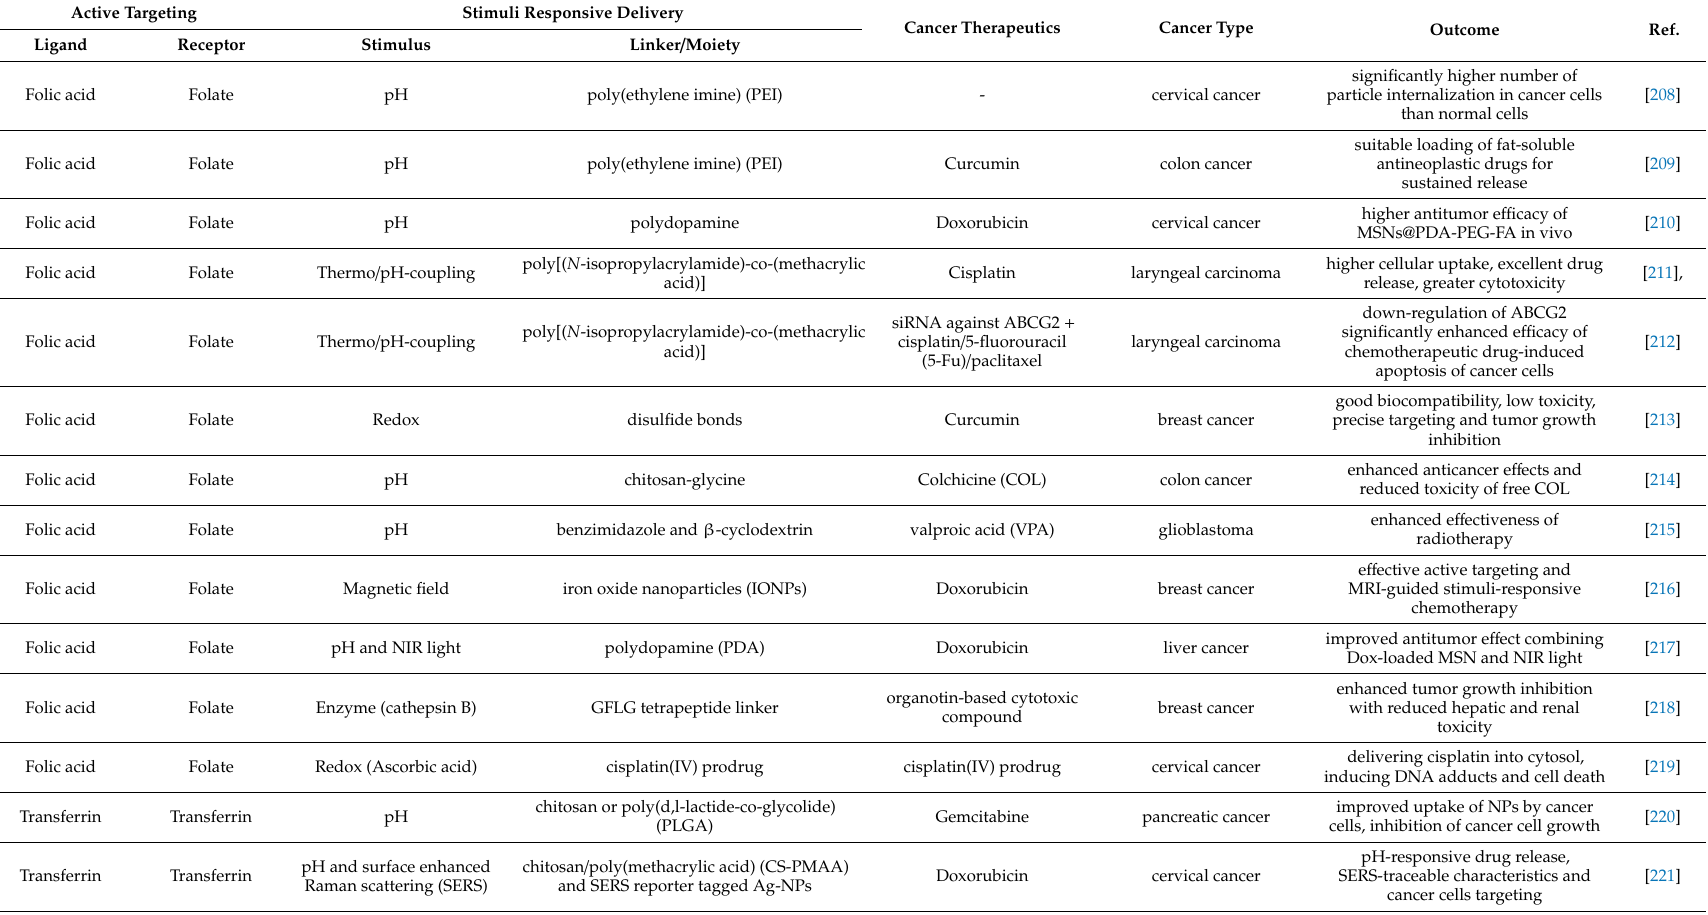
Table 1. Simultaneously employed active targeting and stimuli responsive strategies using MSN in various cancer